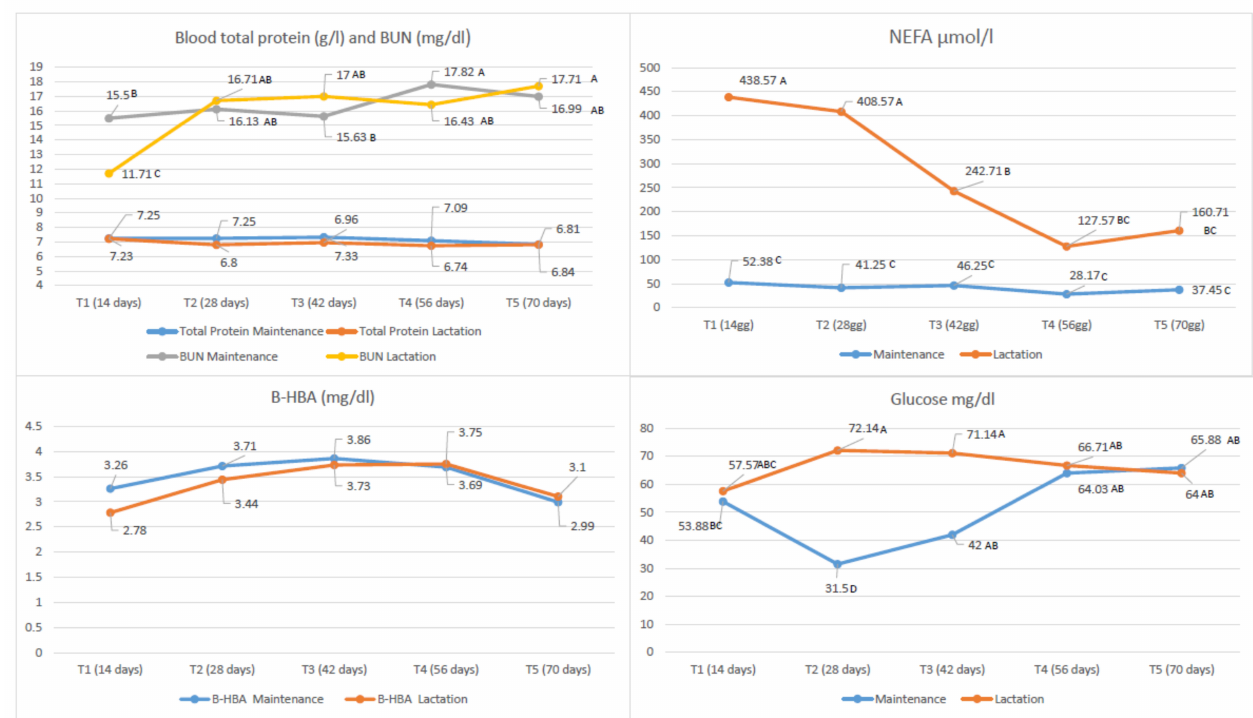
Figure 1. Trend of the blood metabolic parameters evaluated in the lactation and maintenance jennies fed with Diet 2. A,B,C,D = p < 0.01 Abbreviations: BUN: blood urea nitrogen; NEFA = Non Esterified Fatty Acid; B-HBA: Beta-Hydroxybutyrate.